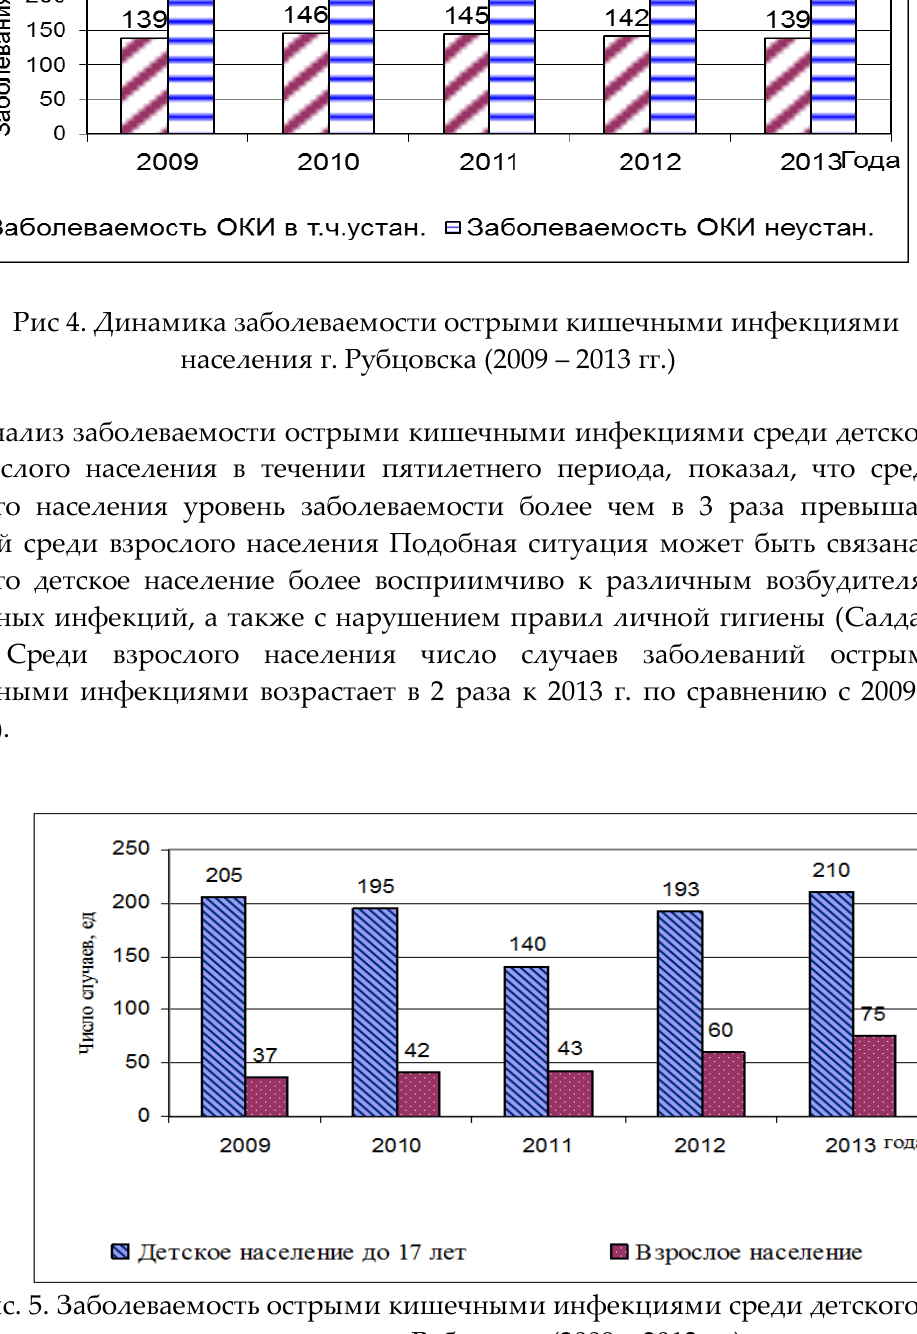
Рис. 5. Заболеваемость острыми кишечными инфекциями среди детского и взрослого населения г. Рубцовска (2009 – 2013